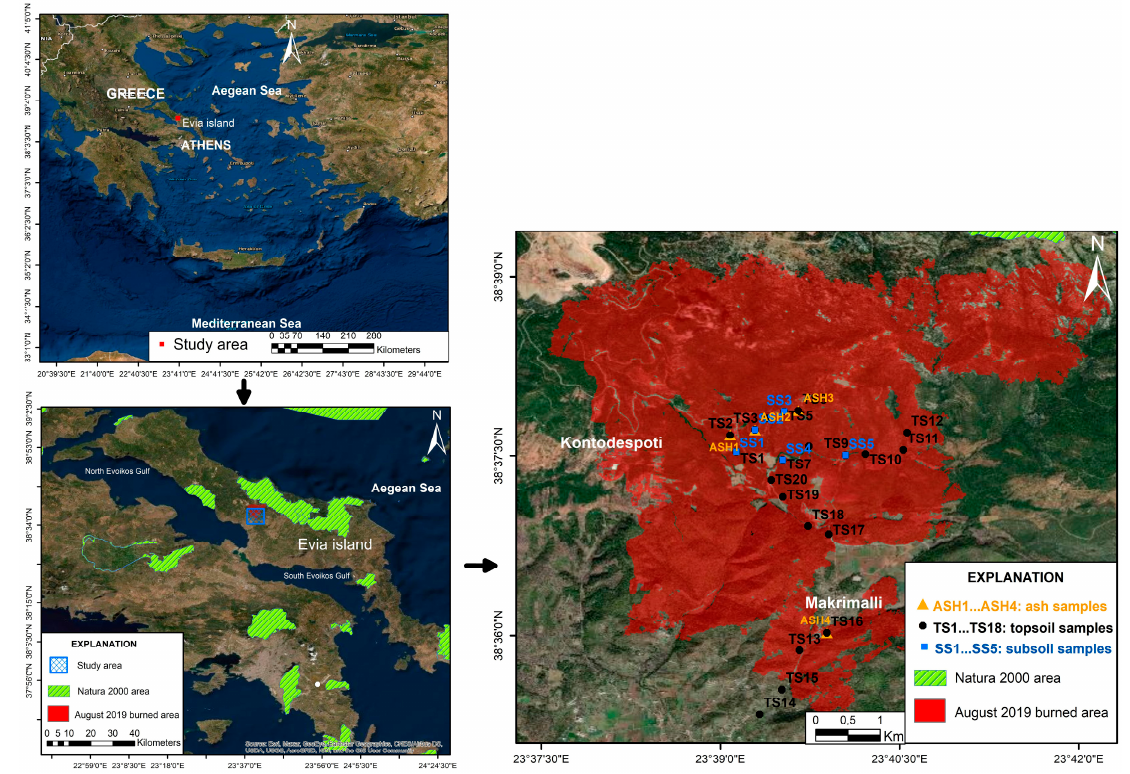
Figure 1. Location map showing area studied, Natura 2000 areas, wildfire impacted area and spatial Figure 1. map showing area studied, Natura 2000 areas, wildfire impacted area and distribution of ash, topsoil and subsoil samples (modified from spatialdistribution of ash, topsoil and subsoil samples (modified from [23,24,26]).